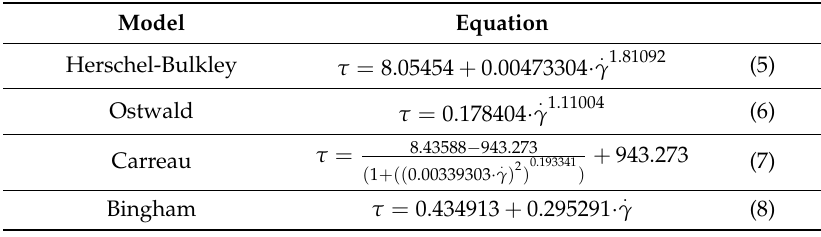
Table 3. Mathematical formulas of rheological models for the AZ91 alloy.